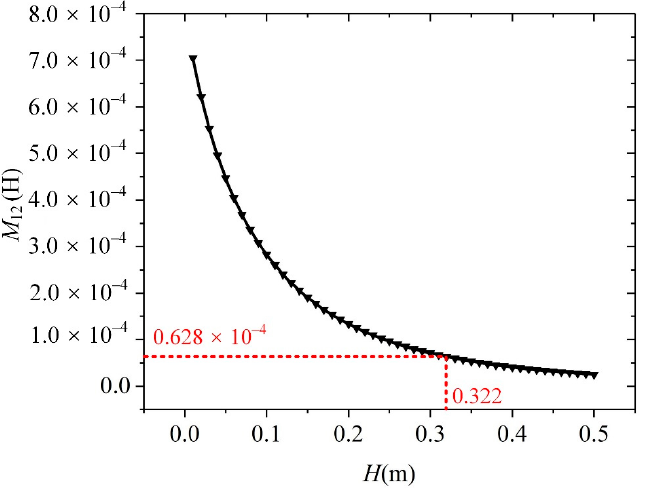
Figure 8. The relationship between M 12 and the transmission distance h